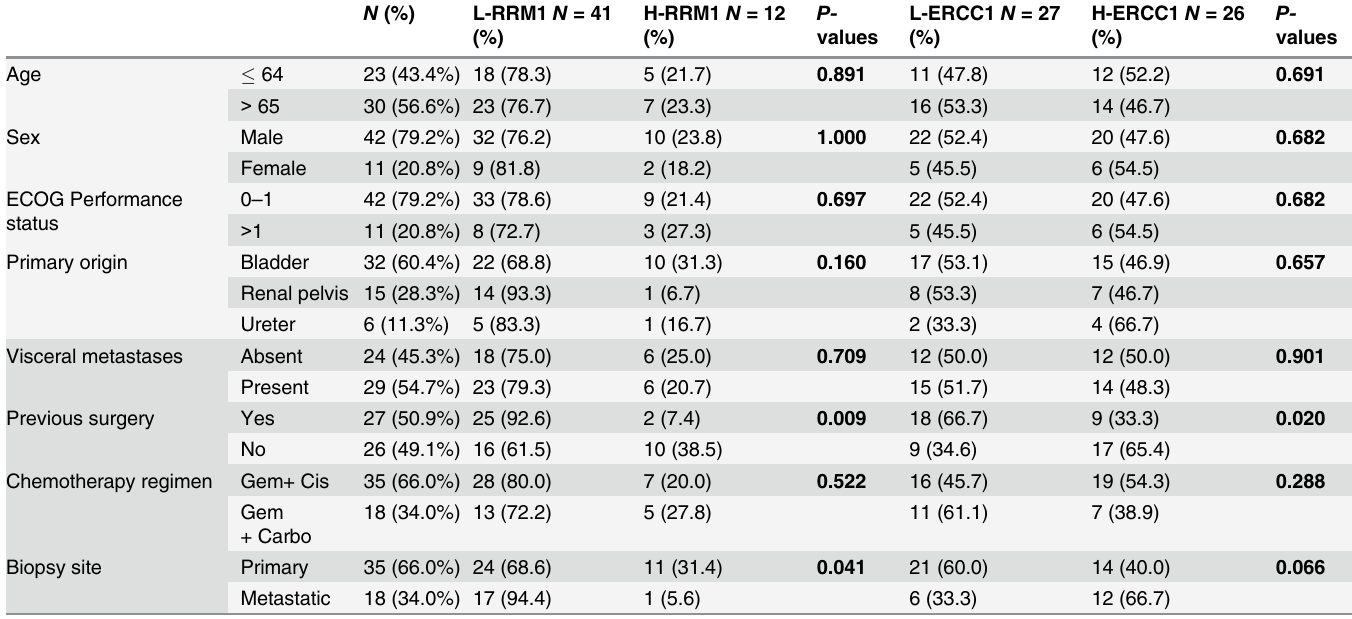
Table 1. Patients ’ characteristics according to RRM1 and ERCC1